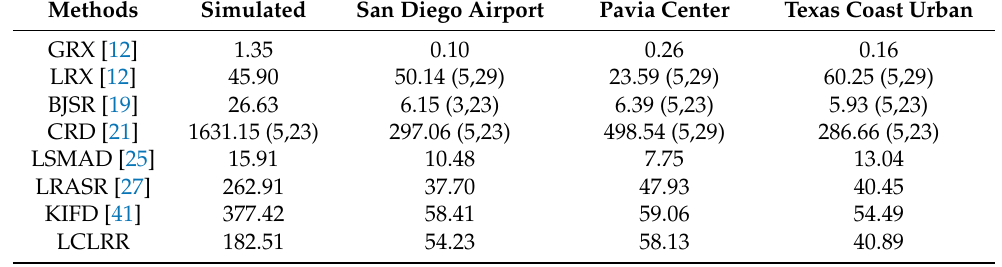
Table 2. The running time (in seconds) of different algorithms for four datasets including the simulated, San Diego airport, Pavia center, and Texas Coast urban.